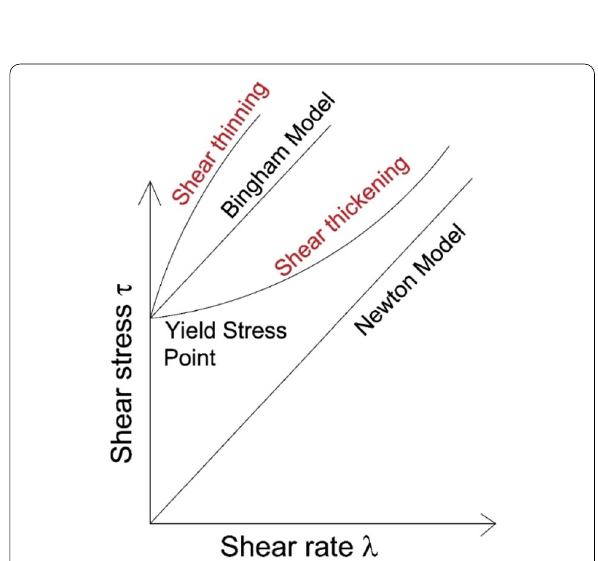
Fig. 4 Bingham fluid behaviour compared with Newtonian